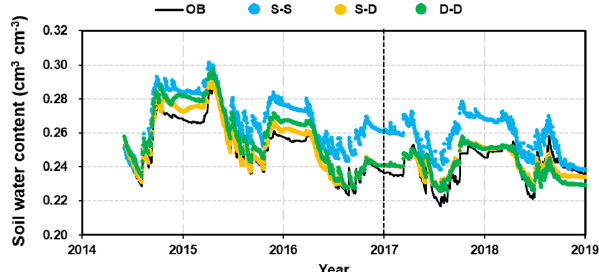
Figure 6. Comparison of the 5m profile-averaged soil water con- tent (SWC) from observations (OB) and the three root simula- tion approaches during the calibration (2014–2016) and valida- tion (2017–2018) periods. The abbreviations used in the figure are as follows: S–S – static rooting depth and static fine-root distri- bution; S–D – static rooting depth and dynamic fine-root distribu- tion; D–D – dynamic rooting depth and dynamic distribution of fine